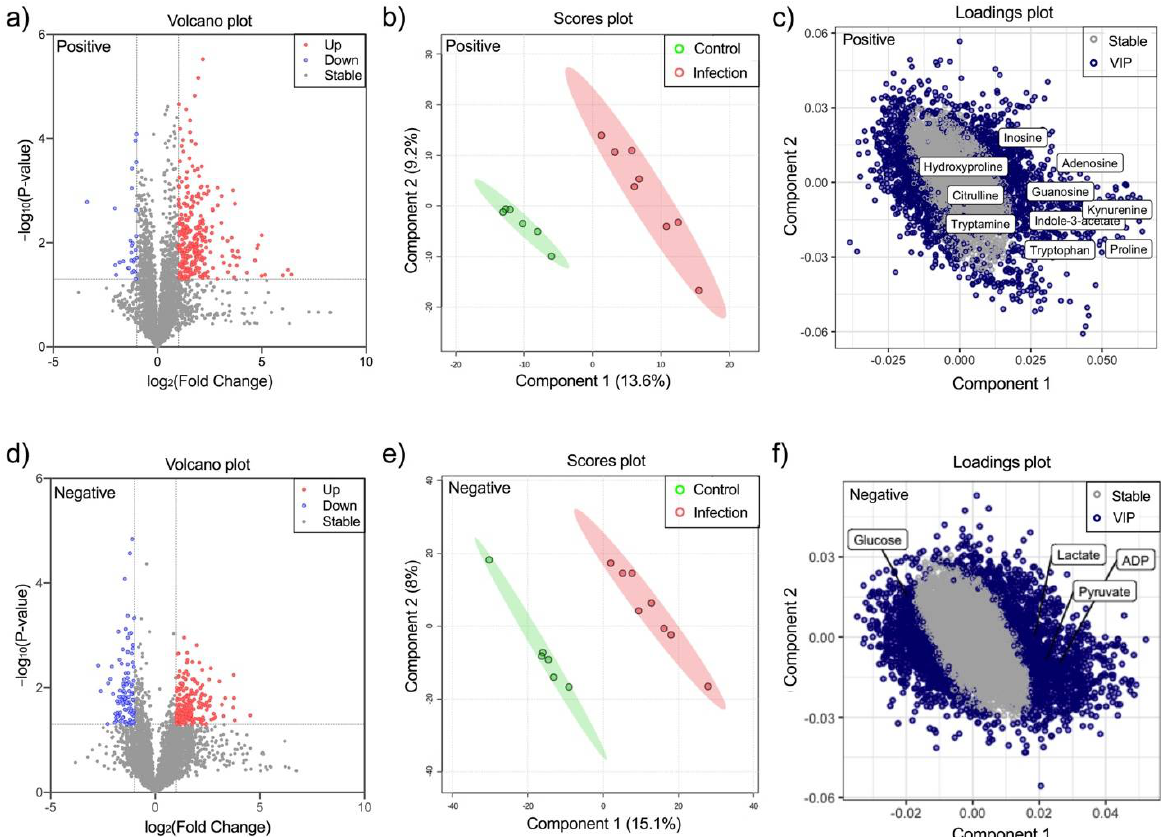
Figure 2. Volcano plots of CSF metabolomic features from infection samples and controls in the positive ion mode ( a ) and negative ion mode ( d ). The features up-regulated and down-regulated in the infection group are plotted in red and blue, respectively. The dotted lines show the threshold as FC = 2 and p value = 0.05. The PLS-DA score plots for CSF metabolomic features from infection samples and controls in the positive ion mode ( b ) and the negative ion mode ( e ). PLS-DA loading plots in the positive ion mode ( c ) and the negative ion mode ( f ).